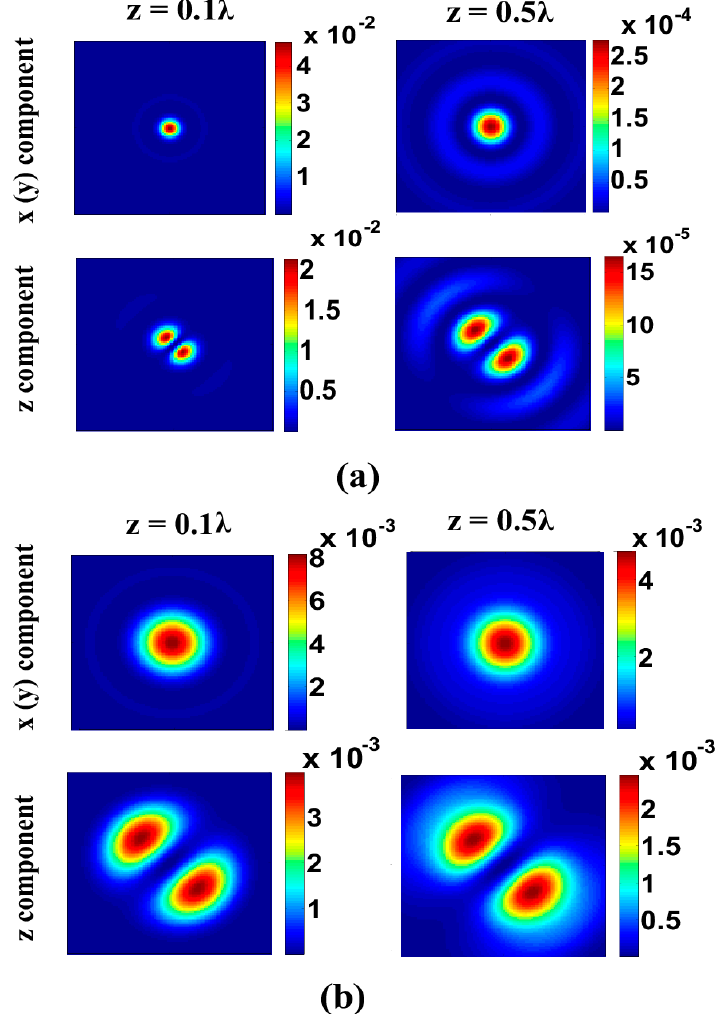
Figure 2. (Color online) Intensity patterns of x -, y - and z - components of the evanescent wave and propagating wave in the x - y plane for different propagation distances with w = 0.1 λ , r 0 = 0.5 λ : ( a ) the evanescent wave; ( b ) the propagating wave. Upper plots in ( a , b ) transverse ( x or y ) component; lower plots in ( a , b ) z component. All the images have the same dimension of 2 × 2 λ 2 .